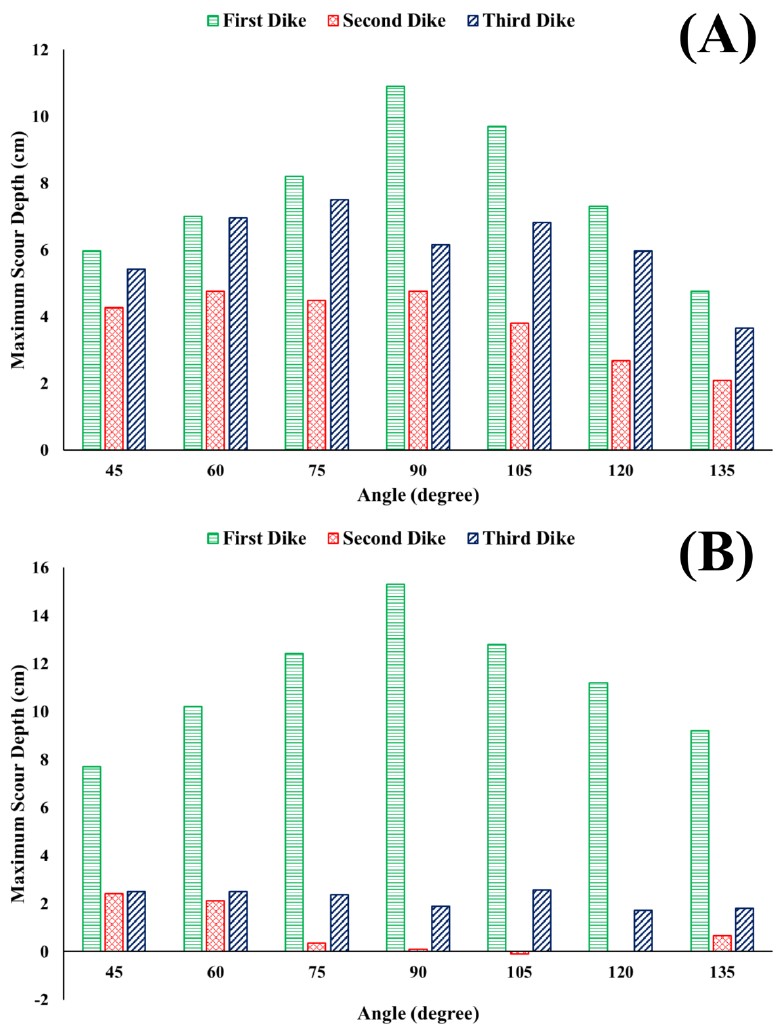
Figure 10. Maximum scour depth under ( A ) descending and ( B ) ascending arrangement.